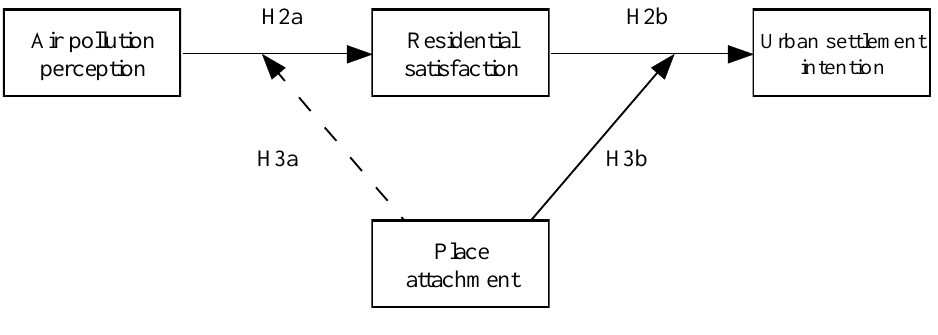
Figure 1. The conceptual model.